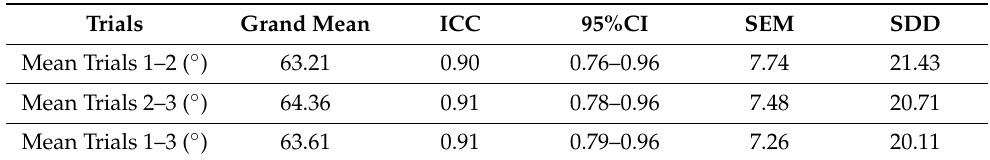
Table 6. Inter-rater reliability of the double inclinometer method for the assessment of thoracolumbar range of movement.